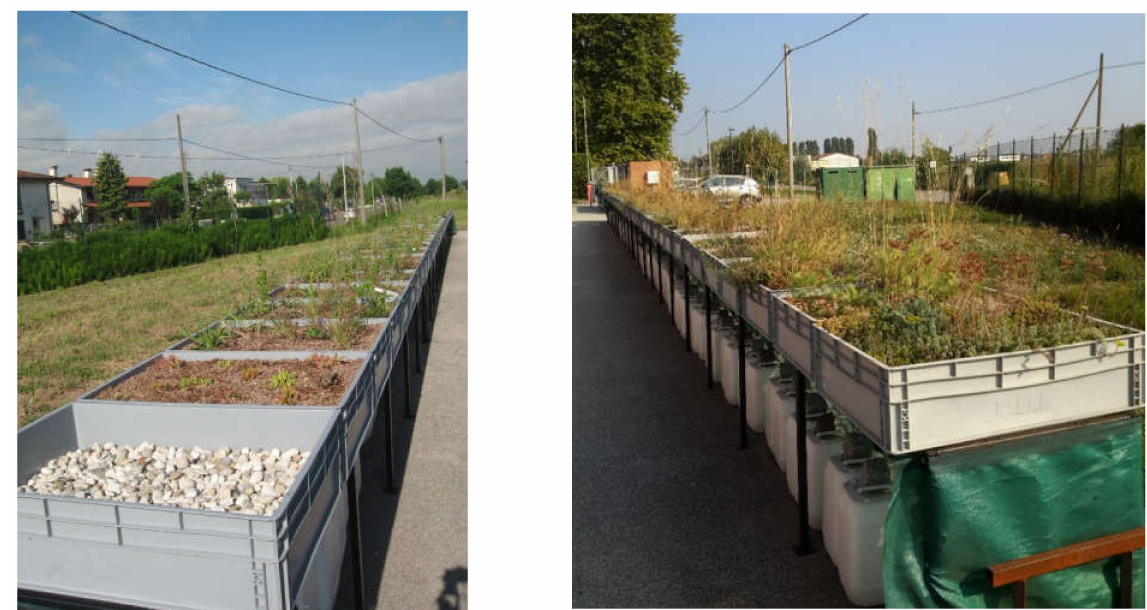
Figure 1. Two photos of the experimental site at the Agripolis Campus: at the beginning in May 2014 ( left ) and at the end in September 2016 ( right ) of the two-year experimental period.